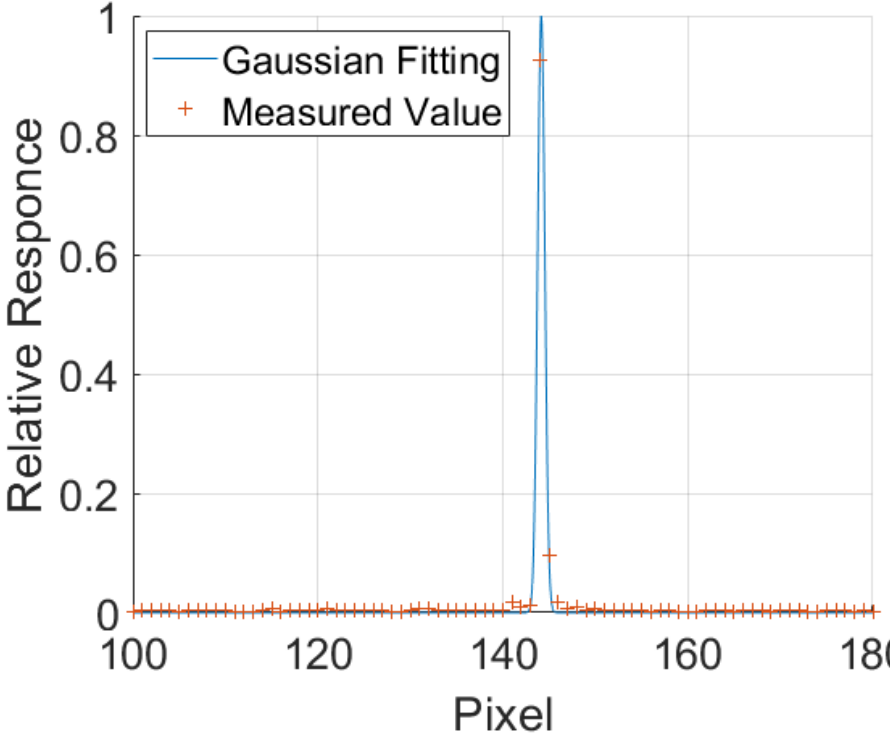
Figure 10. Response of the 120th row of HARIS when receiving an 89.99 ° incident signal and its fitting results, for a central position of 144.15 and a FWHM of 0.92. Using the geometric calibration results, the distortion corrections for HARIS can be determined. The correction method uses the FOV of the 102nd row as the reference, which is located at the center of the image plane, then interpolates the data of the other rows to obtain the corrected image; the results for which are displayed in Figure